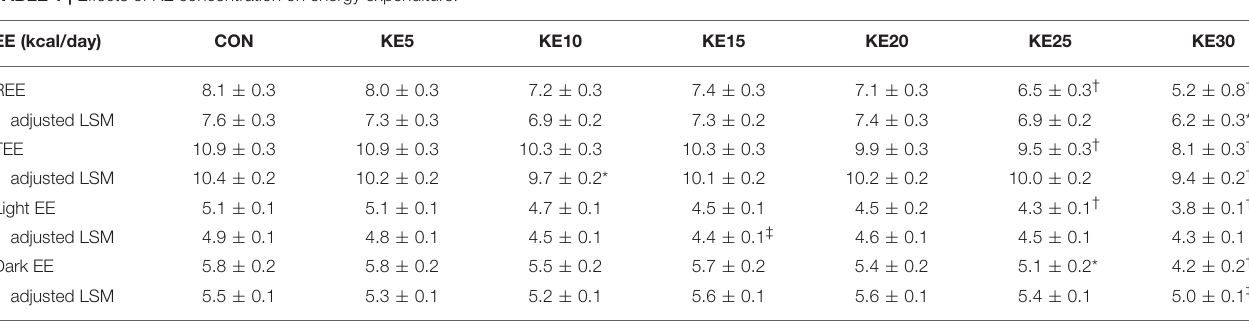
TABLE 1 | Effects of KE concentration on energy